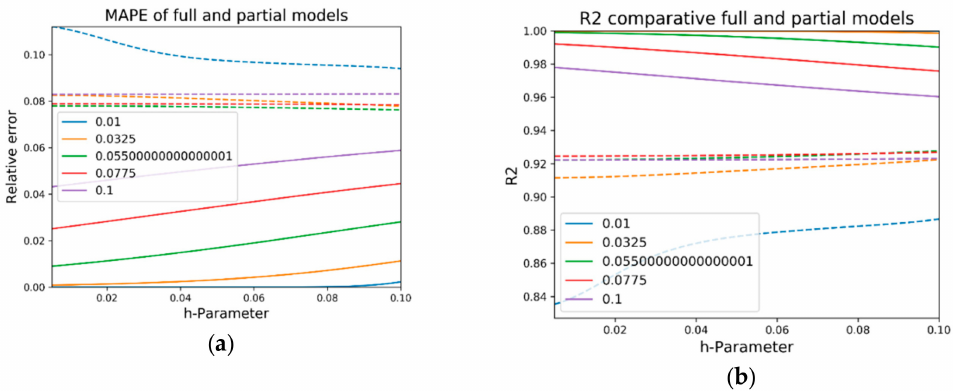
Figure 3. Results for the heating load model depending on the h-parameter. The values of the ω parameter are shown in the legend. Continuous lines represent full models, while discontinuous corresponds to restricted or partial models: ( a ) MAPE; ( b ) R2.